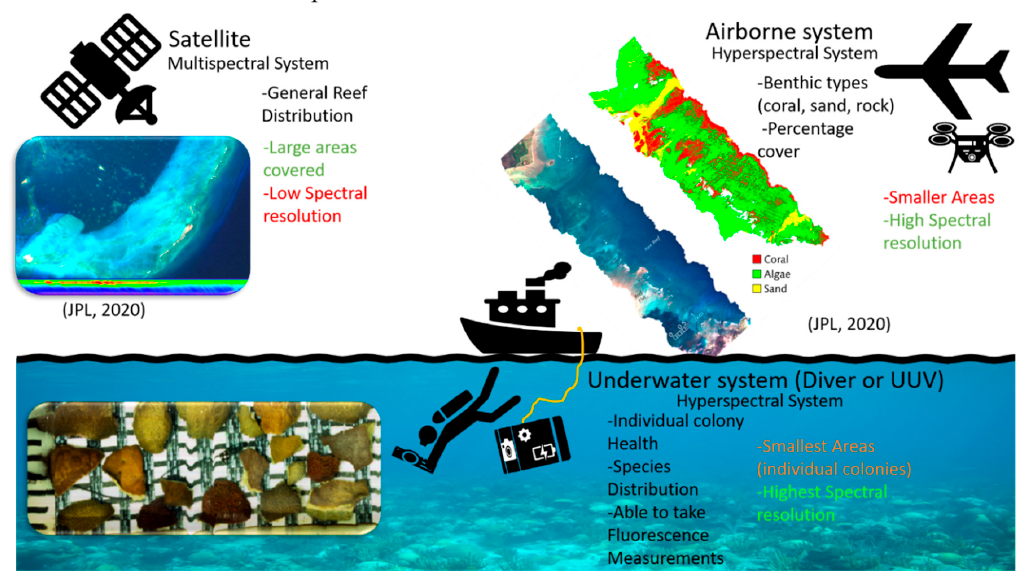
Figure 4. The types of data from each type of spectral system at the different levels from satellites to underwater systems. Images from the Jet Propulsion Lab (JPL) (2020) and Eric J. Hochberg, Bermuda Institute of Ocean Sciences. UUV: Unmanned underwater vehicle.